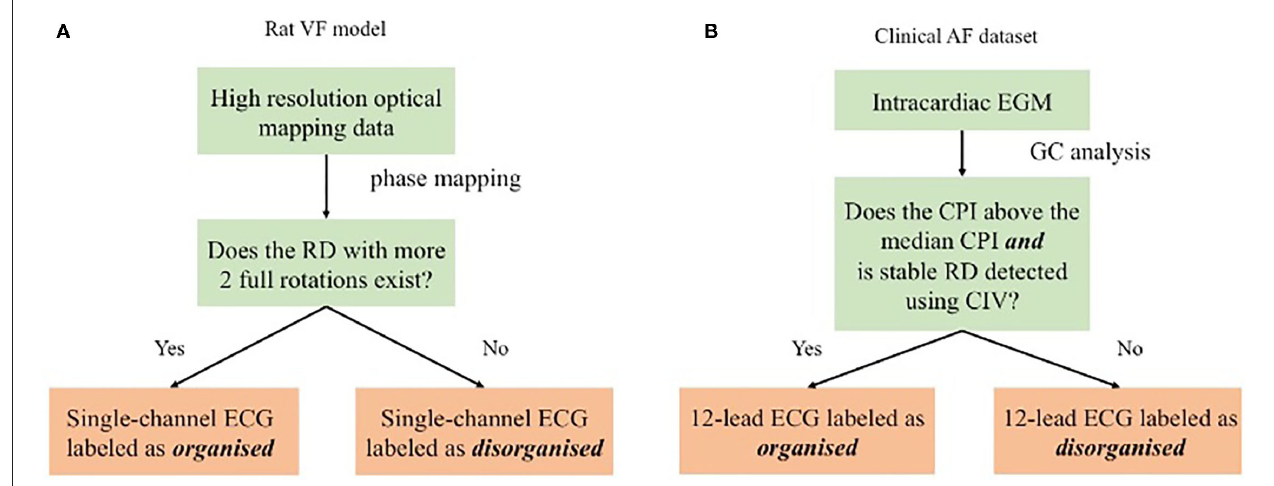
FIGURE 1 | Schematic showing the proposed method evaluated by different sets. For the rat ventricular fibrillation (VF) data, as shown in (A) , the ECG was labelled by the rotational driver (RD) detection results from phase mapping. For the clinical atrial fibrillation (AF) data, as shown in (B) , GC analysis of the electrogram (EGM) data was the surrogate organisation label for the ECG classification.